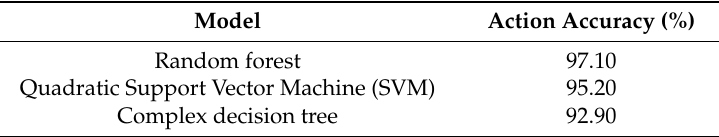
Table 4. Performance accuracies based on 10-fold cross-validation.